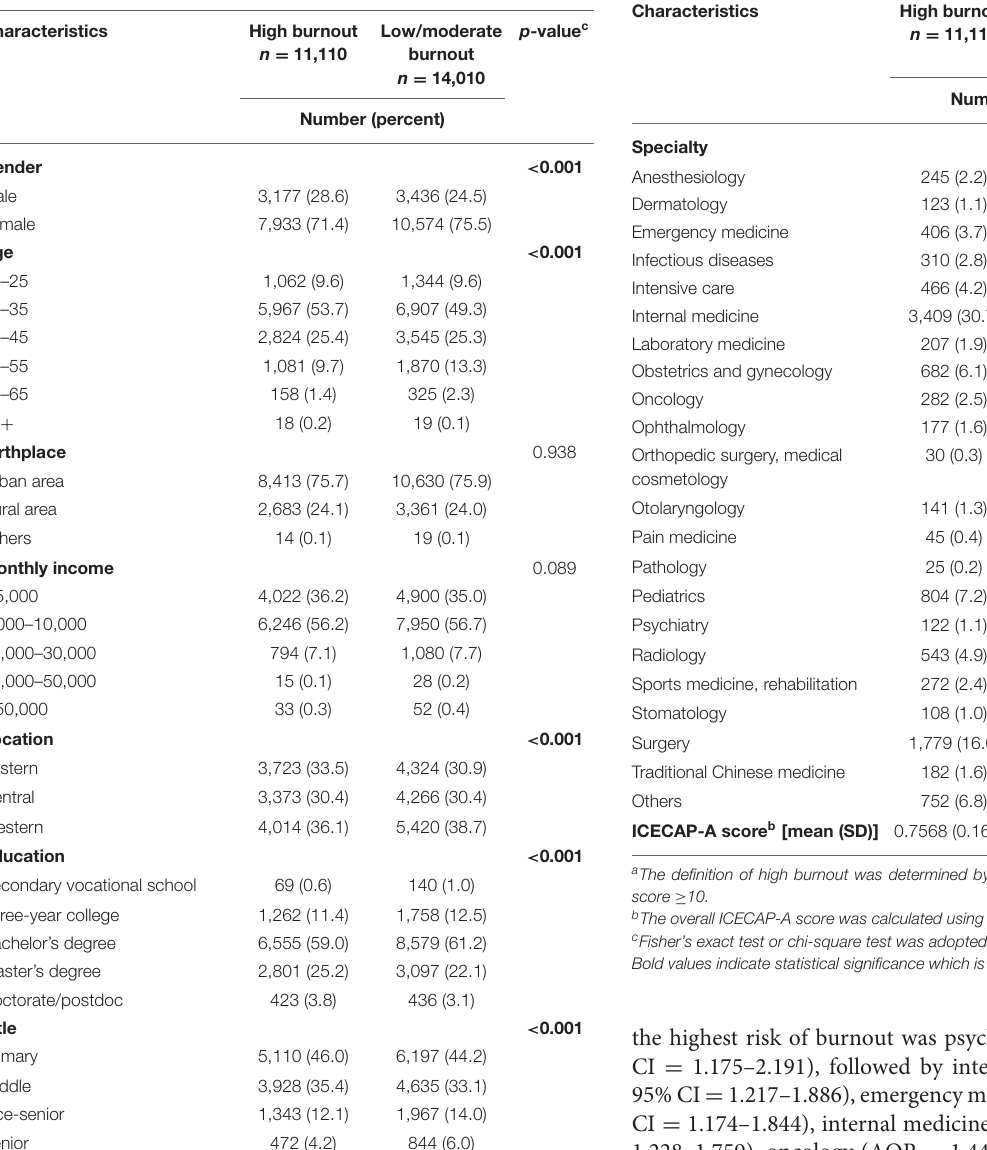
TABLE 4 | Characteristics of Chinese medical professionals associated with high burnout a